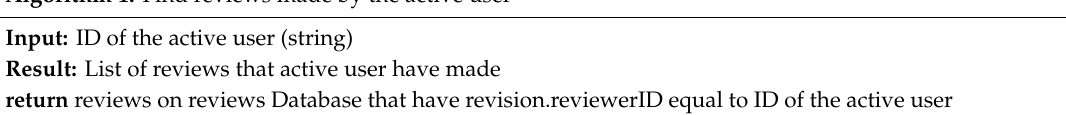
Algorithm 1: Find reviews made by the active